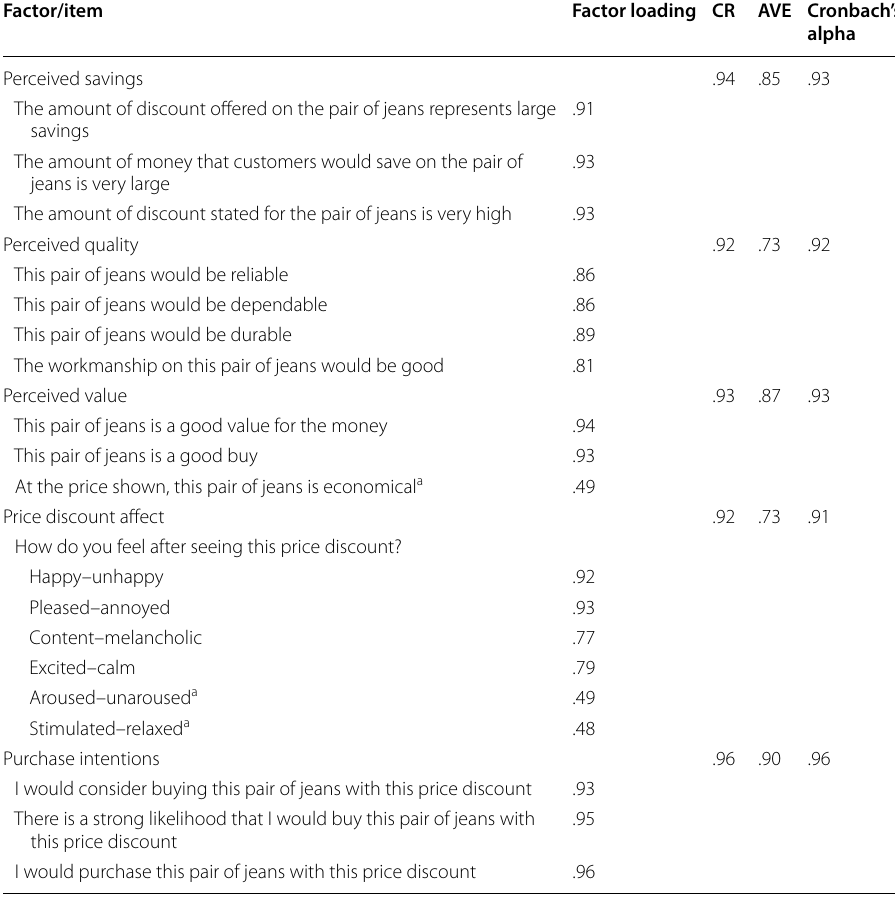
Table 1 Measure items and confirmatory factor analysis